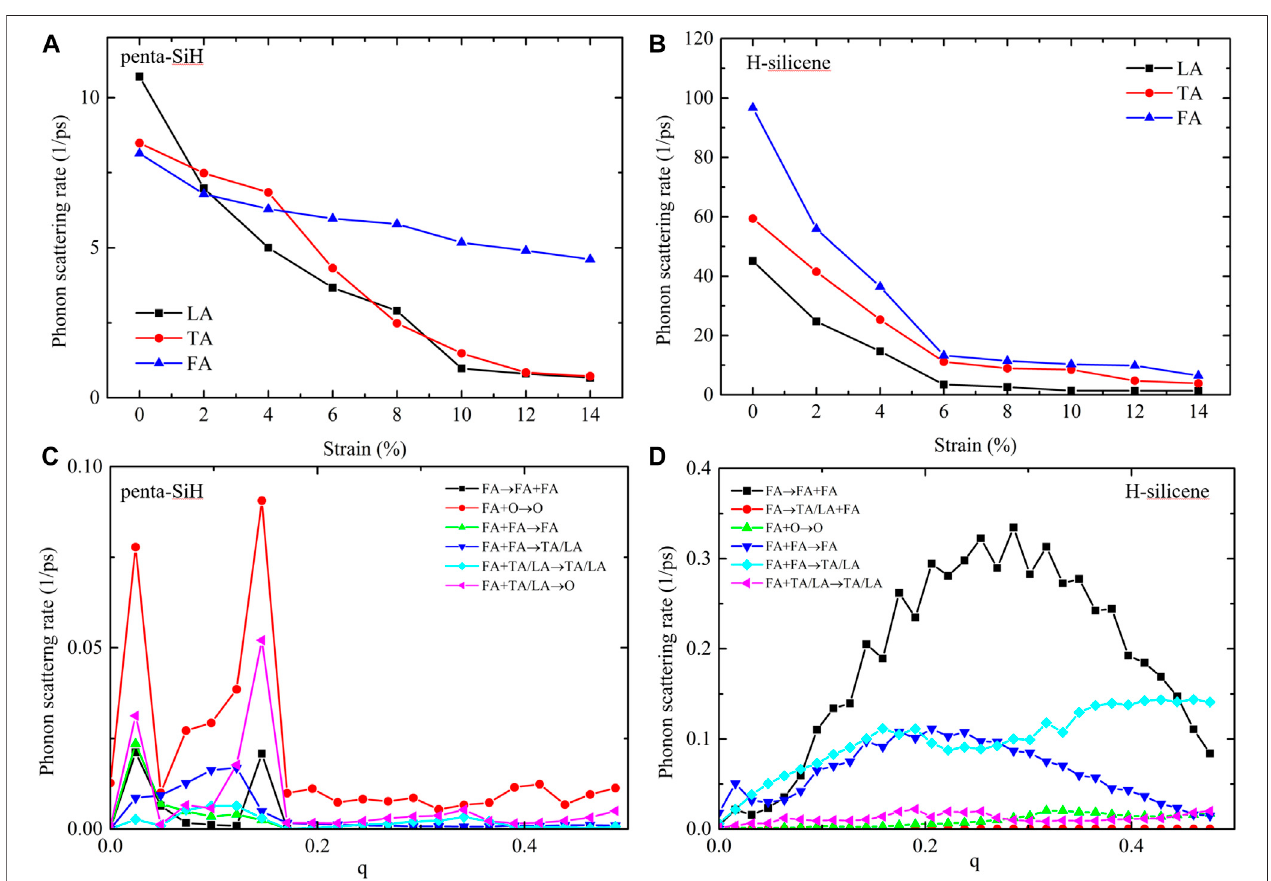
FIGURE 7 | The total phonon scattering rates of FA, TA, and LA modes of penta-SiH (A) and H-silicene (B) . (C) Some typical phonon scattering channels of FA modes in penta-SiH. (D) Some typical phonon scattering channels of FA modes in H-silicene.